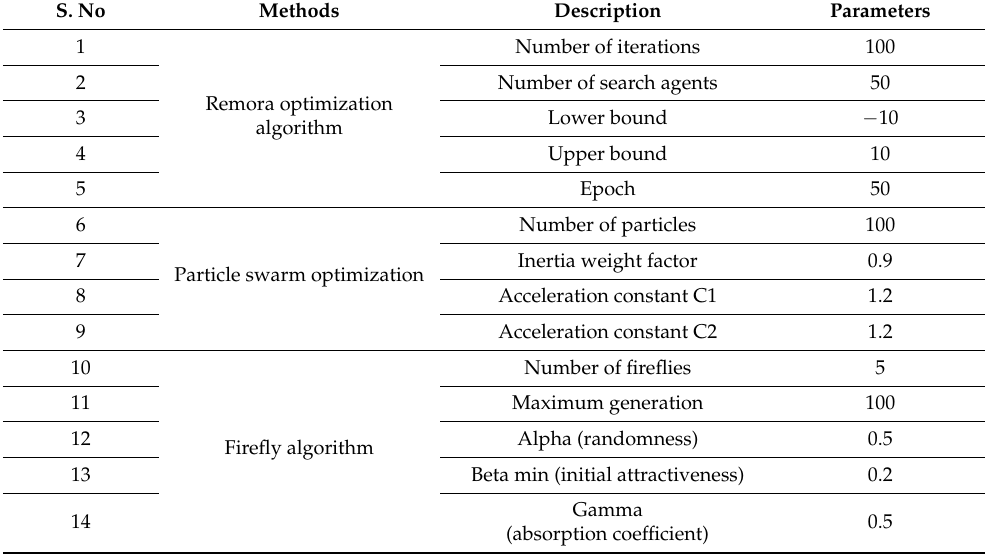
Table 3. Simulation variables.